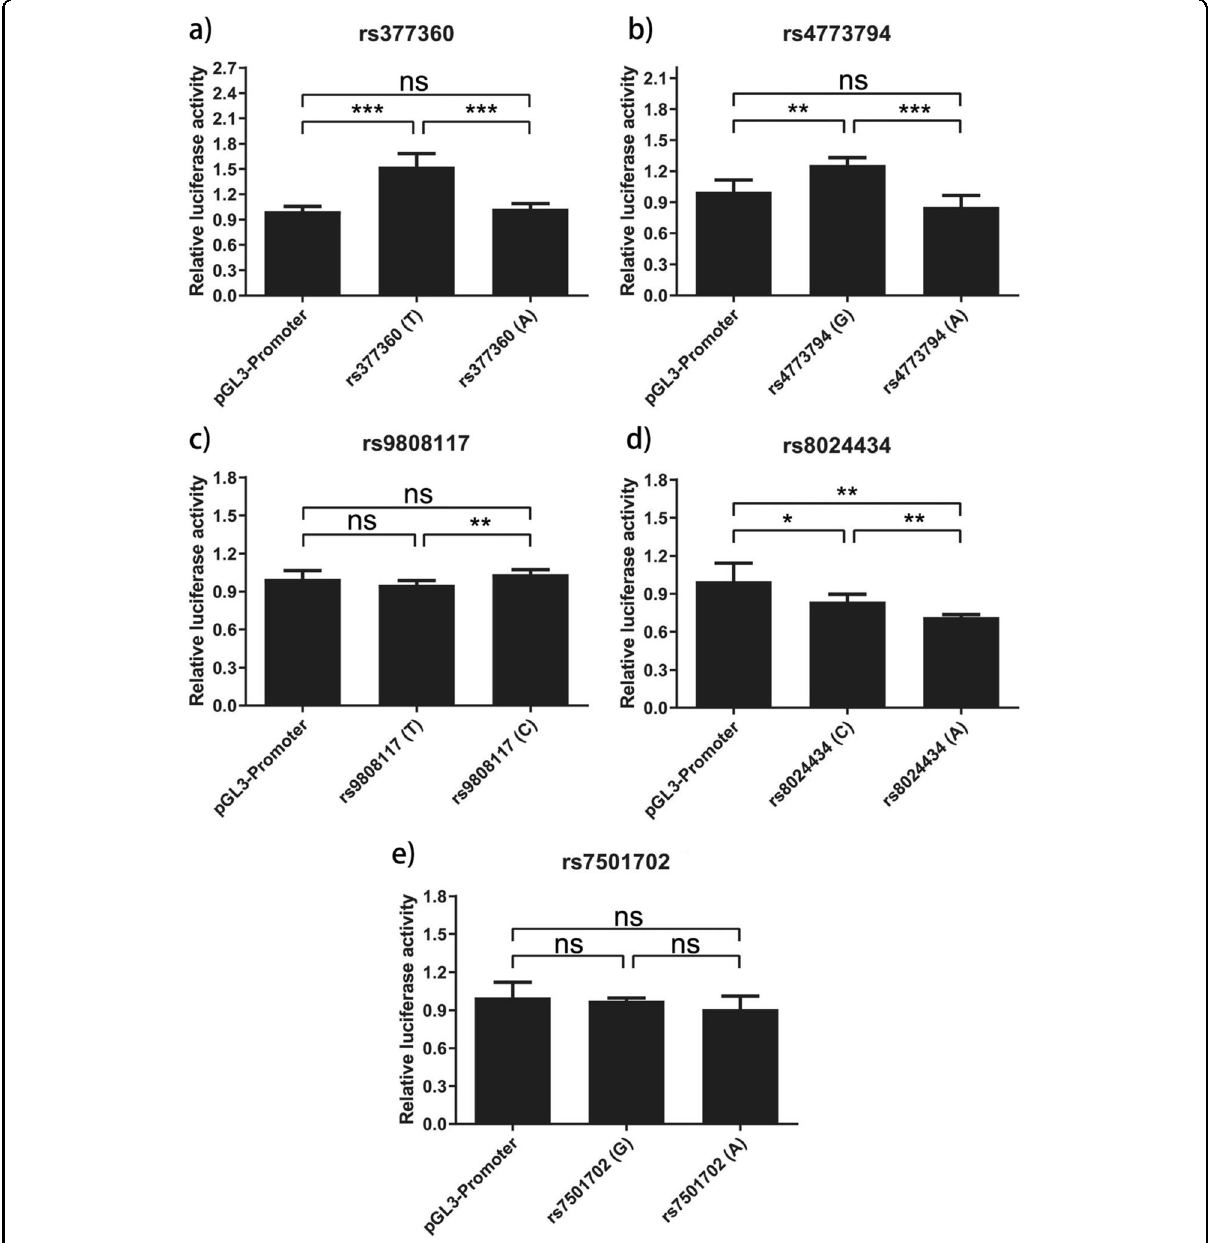
Fig. 5 Luciferase reporter assays comparing transcriptional activation with pGL3-Promoter or variant alleles of genetic variants. a ) rs377360. b ) rs4773794. c ) rs9808117. d ) rs8024434. e ) rs7501702. HEK-293 cells were transfected with luciferase reporter constructs for both alleles of each variant. Each construct was transfected fi ve times and assayed in quintuplicate in each experiment. The luciferase activities, normalized with a cotransfected Renilla activities, were expressed by taking the normalized luciferase activity of the vector (pGL3-Promoter) to be 1. Data represent means±SDs. P values were determined by using the t-test. Signi fi cance indicators will be written above the bars: *** if p < 0·001, ** if p < 0·01, * if p < 0·05,ns